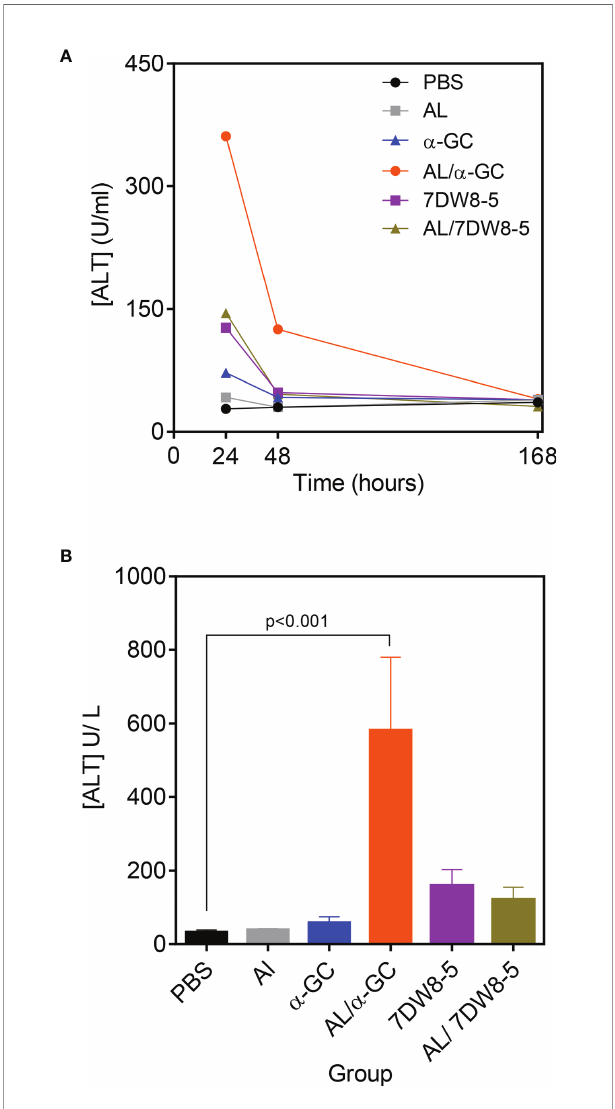
FIGURE 5 | Transient hepatotoxicity on combining Alum and CD1d-binding adjuvants. B6 mice were immunized s.c. with adjuvants indicated singly or in combinat i on and in doses used for other experiments in the study. Heparinized blood samples were collected and pooled and analyzed as described in materials and methods. (A) Graph shows ALT concentration over time and is representative of four independent experiments. Each data point represents pooled blood samples from 3 individual mice. (B) Shows the mean ± SD ALT concentration for 4 experiments at the 24 hr time point. Data were analyzed by ANOVA followed by Dunnett ’ s